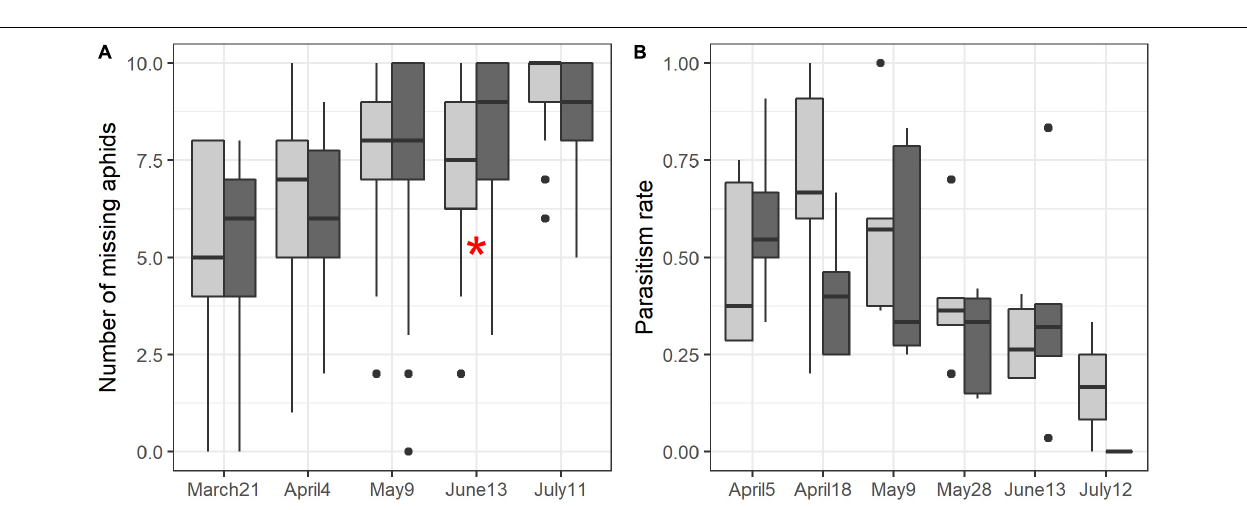
FIGURE 7 | Temporal variations of the abundance per field of the three detected cereal aphids depending on soil management.